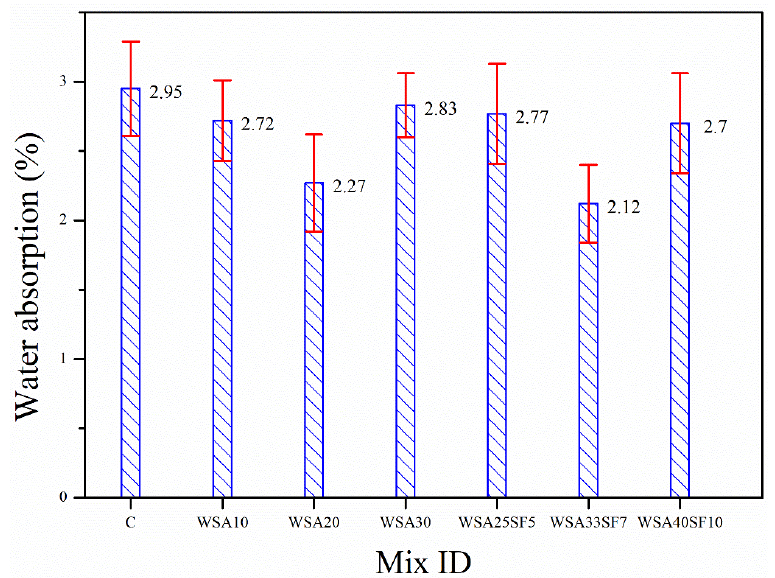
Figure 3. Comparison of the results for water absorption between the control and other concretes (binary and ternary mixes) after 91 days of standard curing.